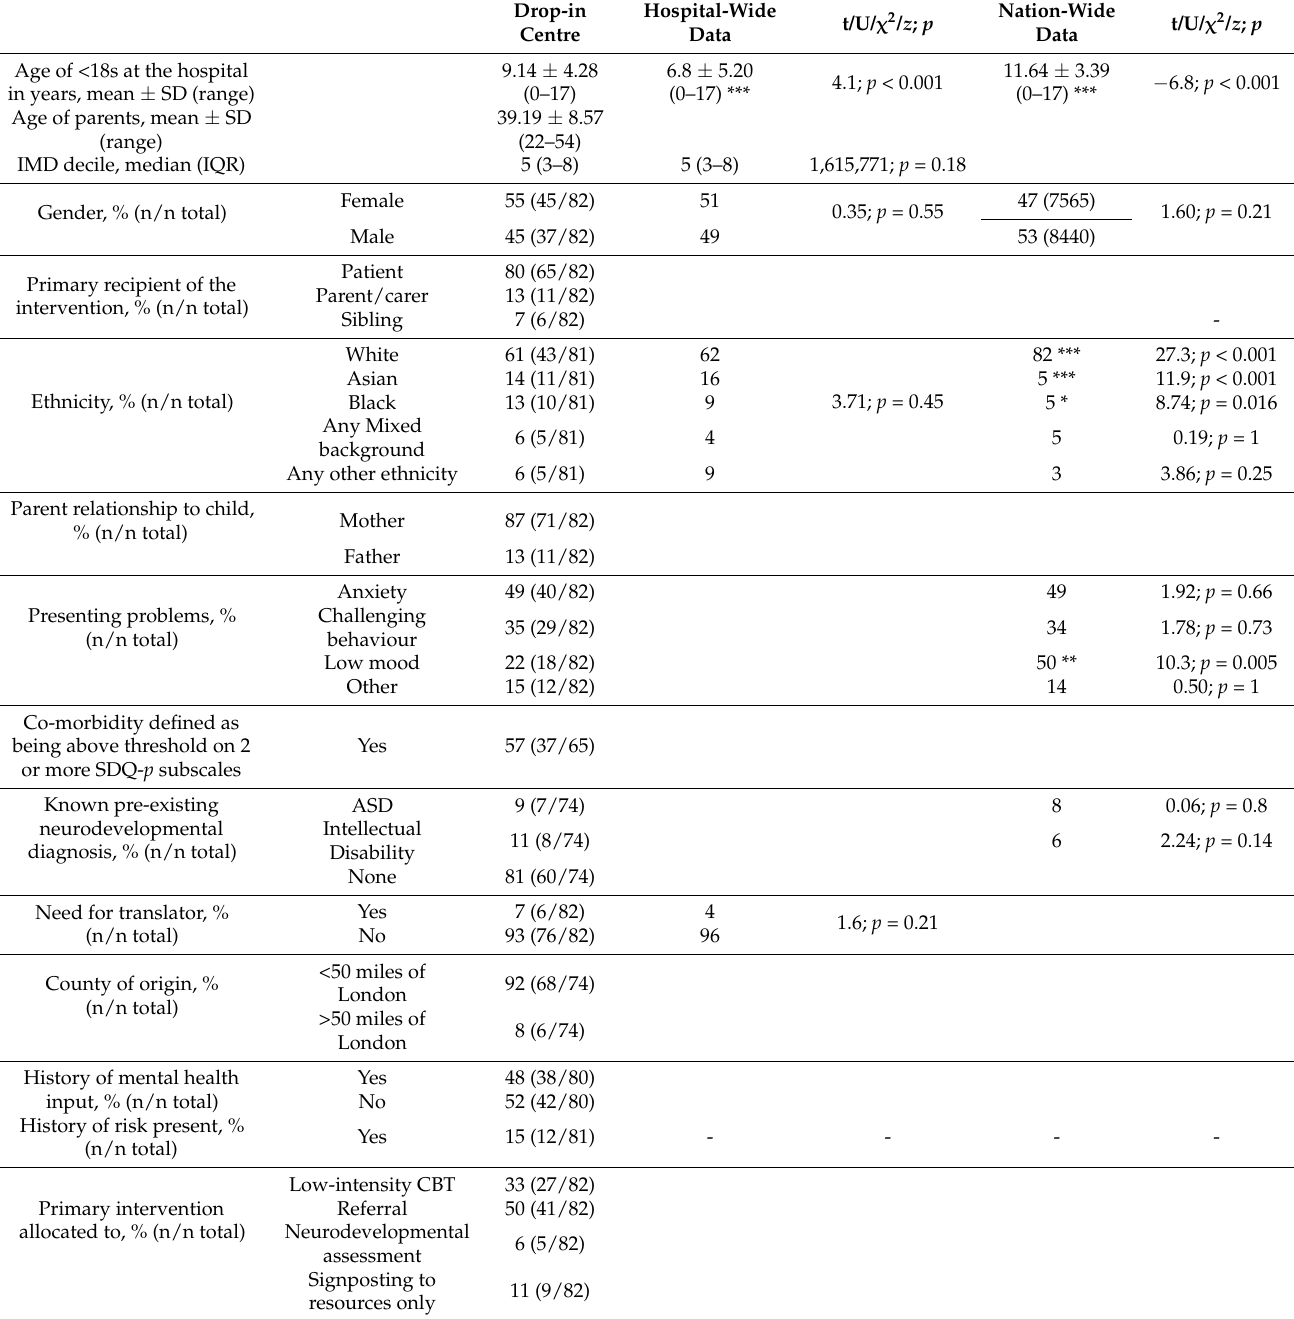
Drop-in Hospital-Wide Nation-Wide t/U/ χ 2 / z ; p t/U/ χ 2 / z ; p Centre Data Data